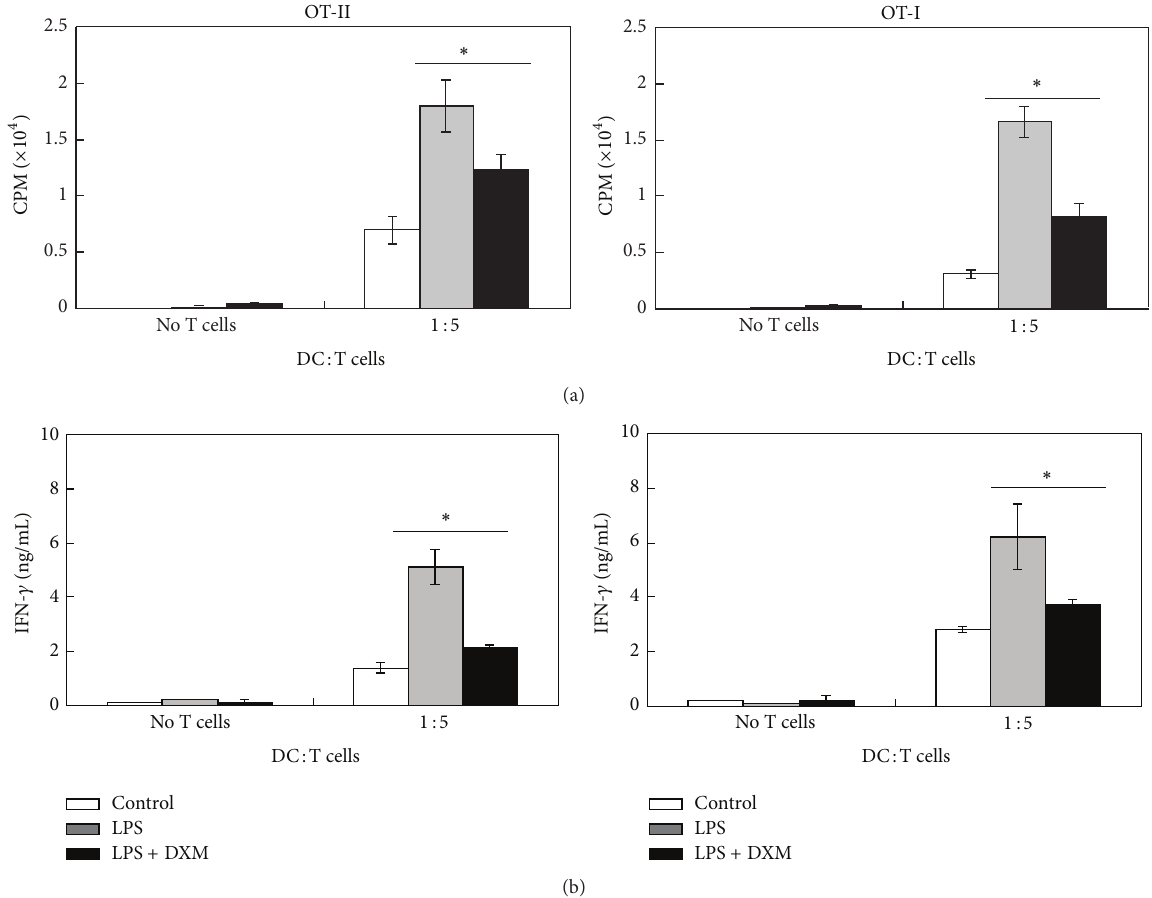
Figure 4: DXM inhibits Ag-specific T-cell activation by LPS-stimulated BMDCs. (a) Either OT-I CD8 + T cells or OT-II CD4 + T cells were cocultured with BMDCs pulsed with OVA peptide and treated with PBS, LPS (100ng/mL) + PBS, or LPS + DXM (50 𝜇 M) at the indicated ratio of DC:T cells for 3 days. The cells were exposed to [ 3 H]-thymidine for 18 h before cell-associated radioactivity was determined. (b) Supernatants were collected from cultures after 4 days. IFN- 𝛾 production was measured by ELISA. The data shown are the mean ± SD of samples of three wells. Significant differences between DXM-treated and untreated LPS-activated BMDCs are shown with asterisks ( ∗ 𝑃 < 0.05 ). All data are representative of three independent